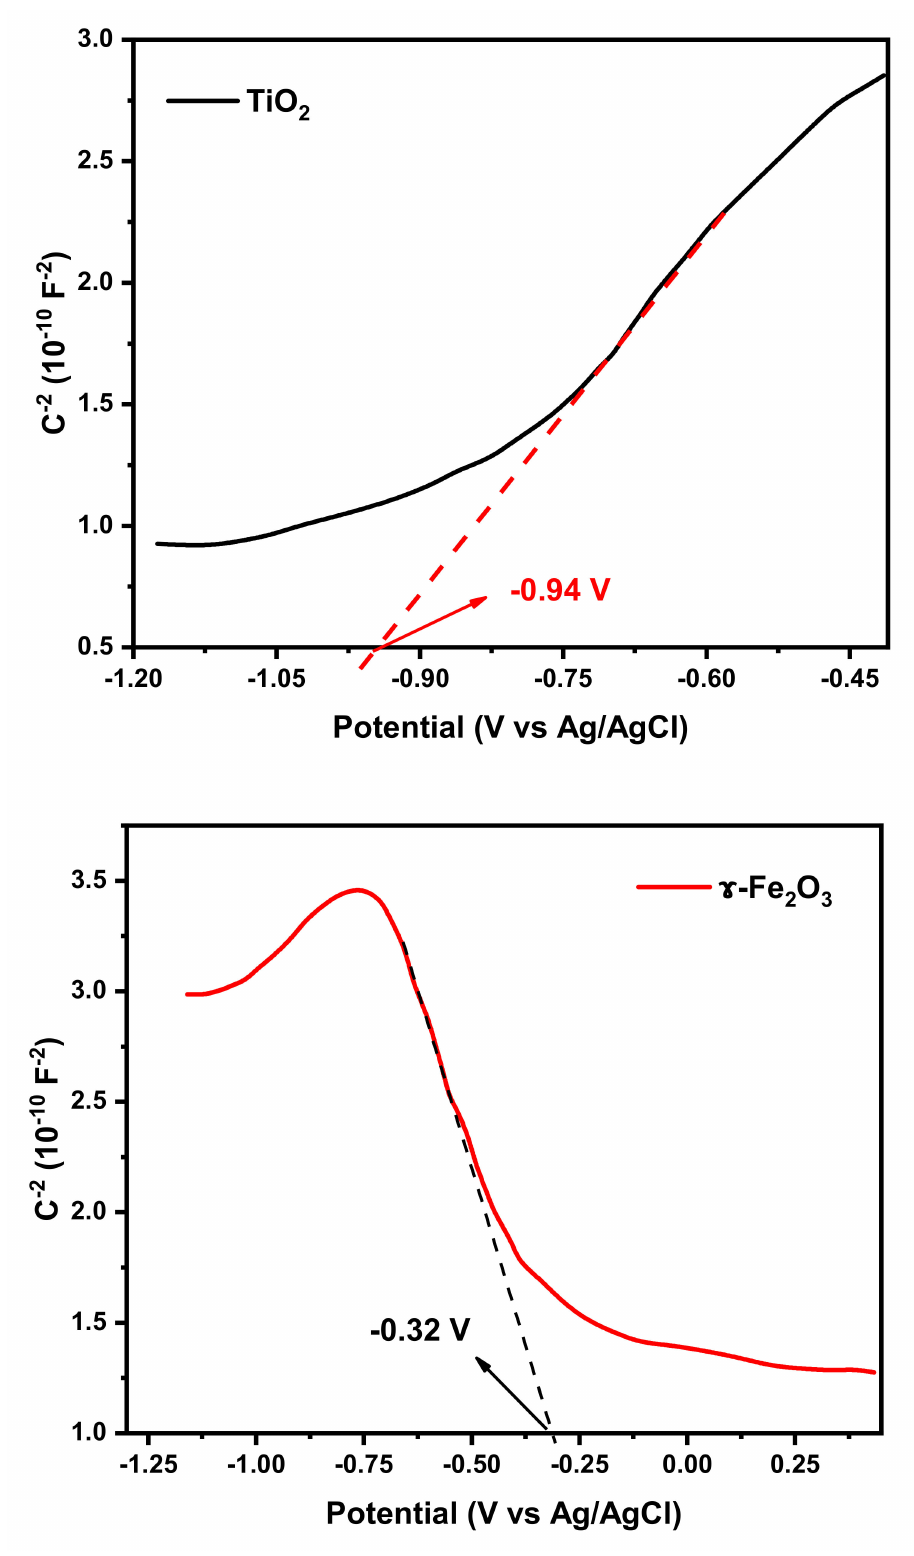
Figure 11. Mott–Schottky plots for TiO 2 and γ -Fe 2 O 3